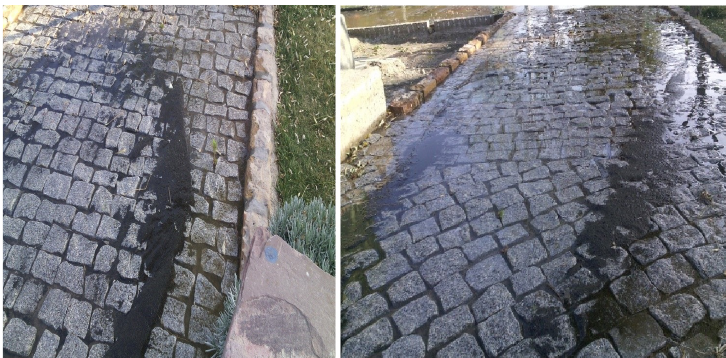
Fig. 2. Discharged sand from hydrocyclone before conducting